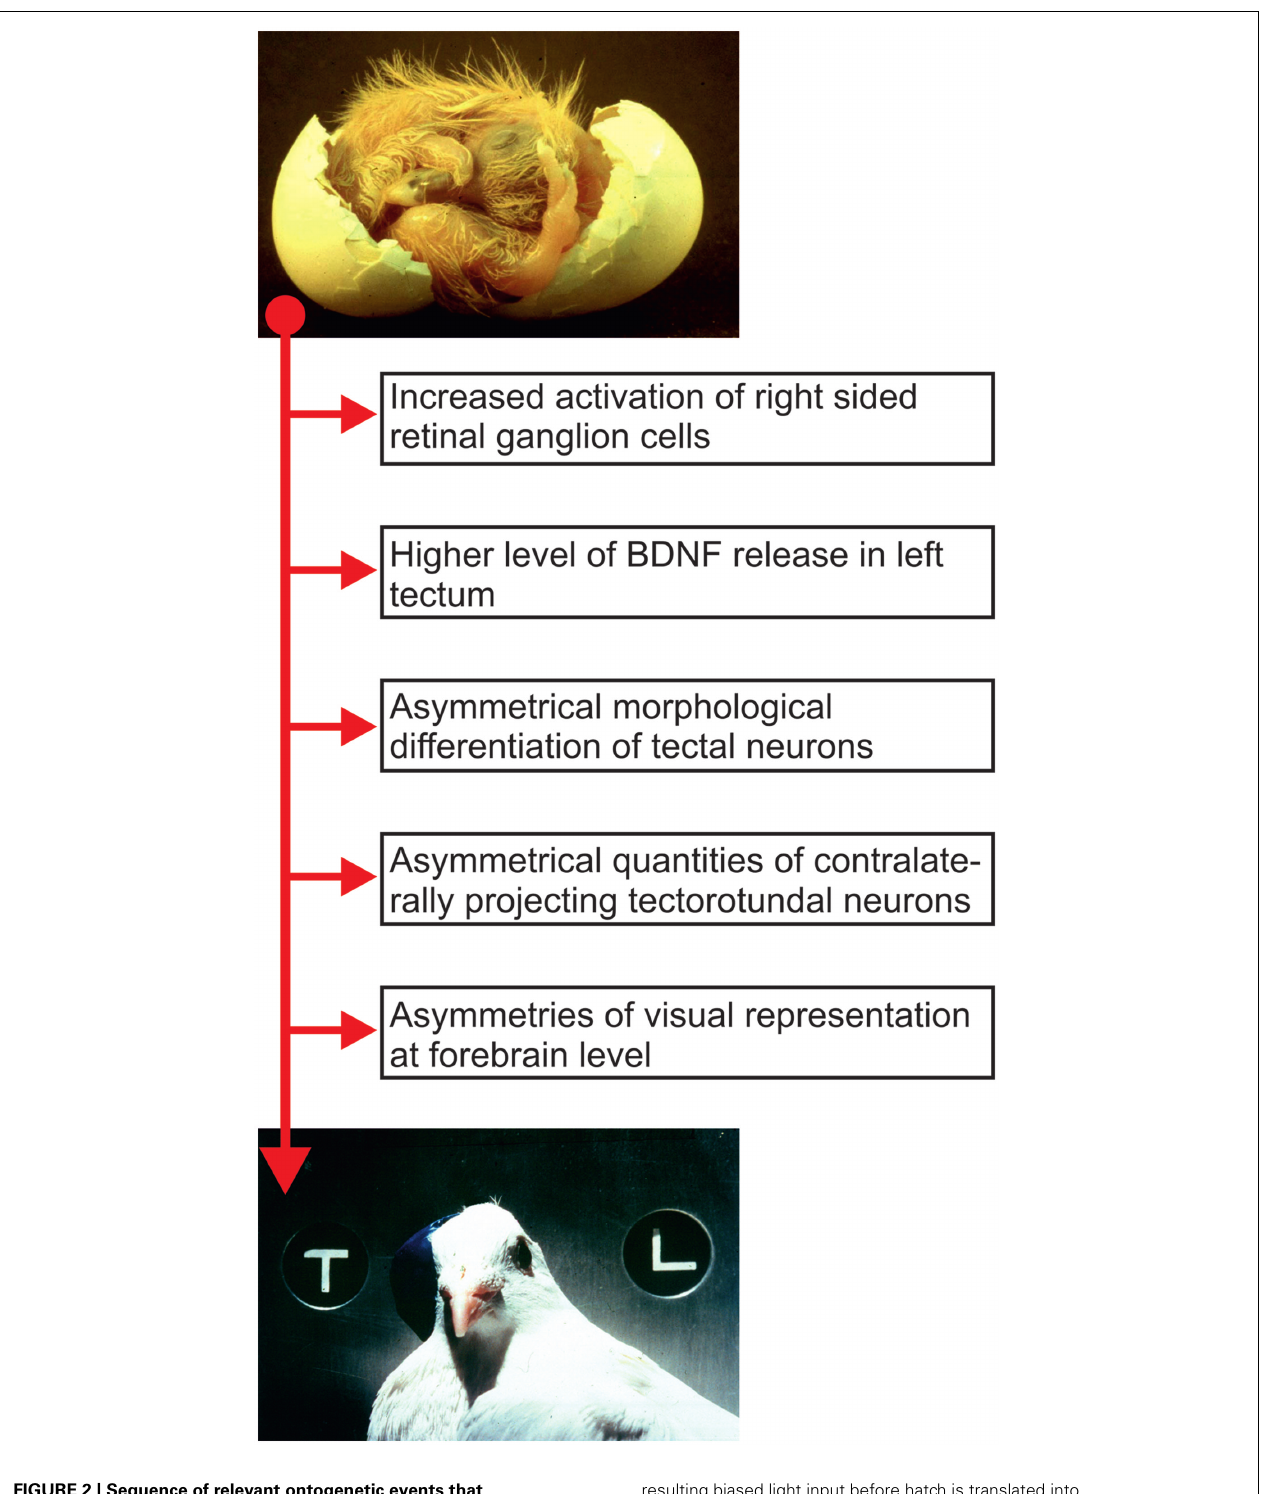
FIGURE 2 | Sequence of relevant ontogenetic events that possibly constitute components of the development of visual asymmetry in pigeons. The top picture shows a pigeon embryo during hatch. Note the position of the head that is turned to the right such that the right eye is positioned close to the eggshell.The